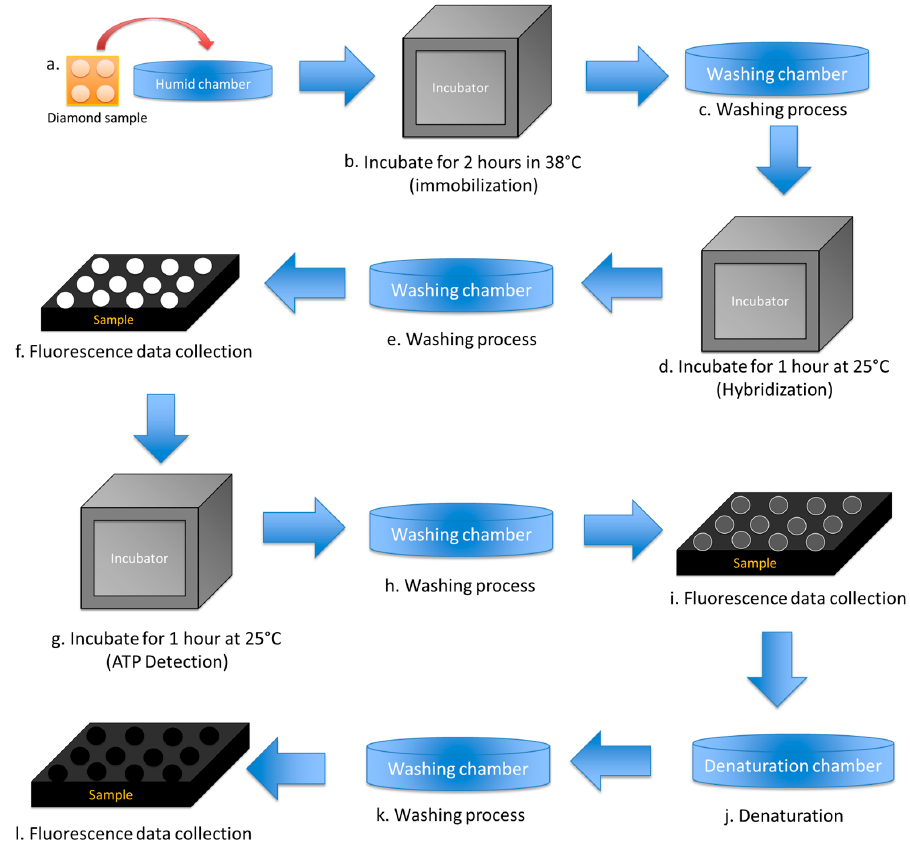
Figure 3. Experimental setup for data measurement. ( a ) Biomolecule dropped onto the surface and placed in the humid chamber; ( b ) Incubation for 2 h at 38 °C for the immobilization process; ( c ) Washing treatment; ( d ) Hybridization; ( e ) Washing treatment; ( f ) Fluorescence data collection for hybridization; ( g ) Incubate for 1 h at 25 °C for ATP detection; ( h ) Washing treatment; ( i ) Fluorescence data collection for ATP detection; ( j ) Denaturation treatment; ( k ) Washing treatment; ( l ) Fluorescence data collection for denaturation.